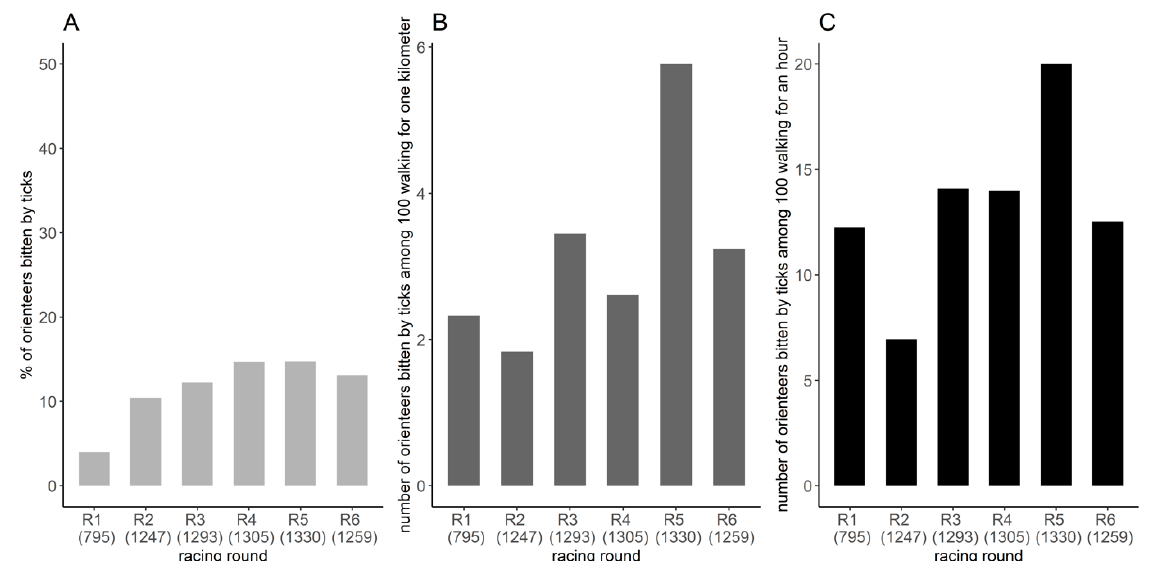
Figure A1. Frequency of tick bites per racing round. ( A ) Minimal proportion of orienteers bitten by ticks per racing round and its 95% confidence interval, estimated by the number of orienteers reporting tick-bites on the banner and by submitting ticks divided by the number of orienteers running the competition. Exposure index of the minimal number of orienteers bitten by ticks among 100 orienteers walking ( B ) one kilometer or for one hour ( C ). The number in parentheses represents the number of orienteers running the racing round.